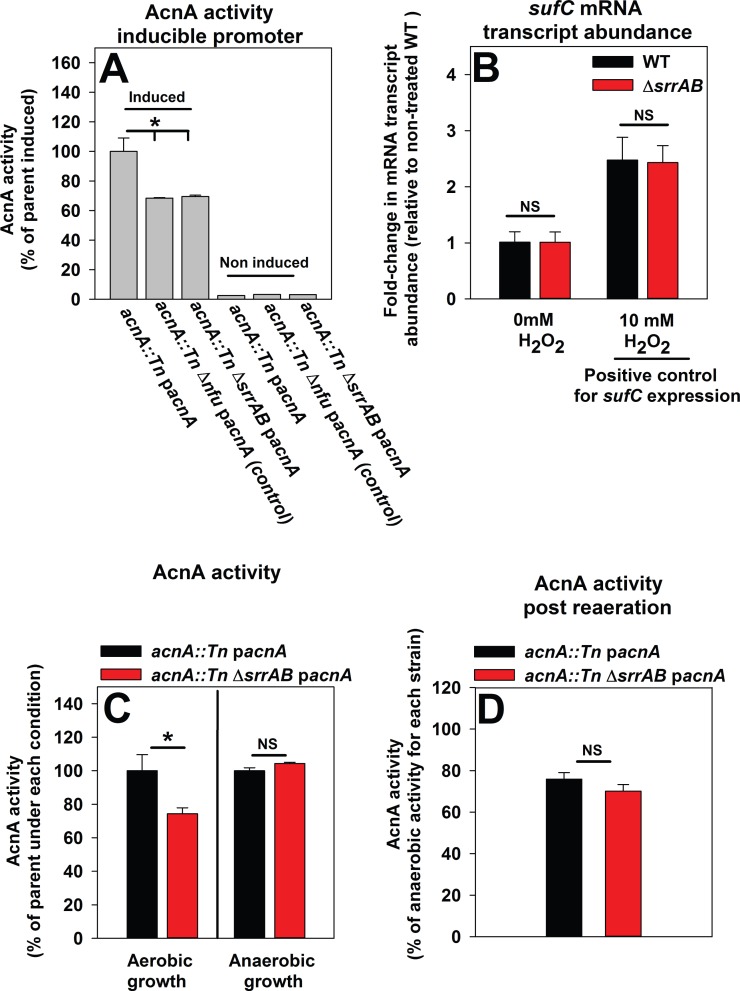
A ΔsrrAB strain incurs increased damage to aconitase when cultured aerobically.Panel A; The activity of aconitase (AcnA) is decreased in a ΔsrrAB mutant and this phenotype is independent of acnA transcription levels. AcnA activity was assessed in the acnA::Tn (JMB 3537; parent), acnA::Tn Δnfu (JMB 3538), and acnA::Tn ΔsrrAB (JMB 4367) strains carrying pacnA, which contains acnA under the transcriptional control of a xylose inducible promoter. Strains were cultured aerobically in the presence (induced) or absence (not induced) of 1% xylose. Panel B; The sufC mRNA transcript accumulates to similar levels in the WT and ΔsrrAB strains. The WT (JMB1100) and ΔsrrAB (JMB1467) strains were cultured aerobically and challenged with either 10 mM H2O2 or vehicle control and the abundance of the sufC mRNA transcript was quantified. Data were normalized to the 16s rRNA transcript levels and are presented as fold-change relative to the WT strain. Panel C; The activity of AcnA is similar in the WT and ΔsrrAB strains when cultured anaerobically. AcnA activity was assessed in the acnA::Tn (JMB 3537; parent) and acnA::Tn ΔsrrAB (JMB 4367) strains carrying pacnA that were cultured either aerobically or anaerobically. Panel D; A ΔsrrAB mutant does not display increased dioxygen damage to AcnA. The acnA::Tn (JMB 3537; parent) and acnA::Tn ΔsrrAB (JMB 4367) strains carrying pacnA were cultured anaerobically for 4.5 hours, treated with a protein synthesis inhibitor (100 μg mL-1 rifampicin) and either exposed to dioxygen or incubated anaerobically for 35 minutes subsequent to determining the activity of AcnA. Data in Panels A-D represent the average of biological triplicates. Where indicated, two-tail student t-tests were performed on data and * denotes p< 0.05 and NS denotes not significant.